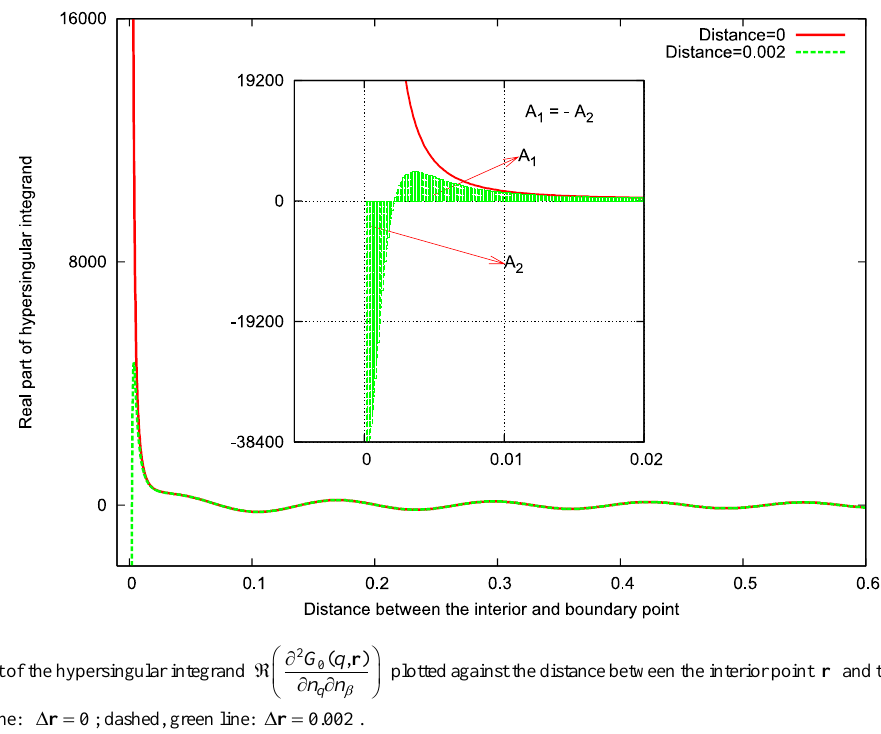
r plotted against the distance between the interior point r and the boundary point